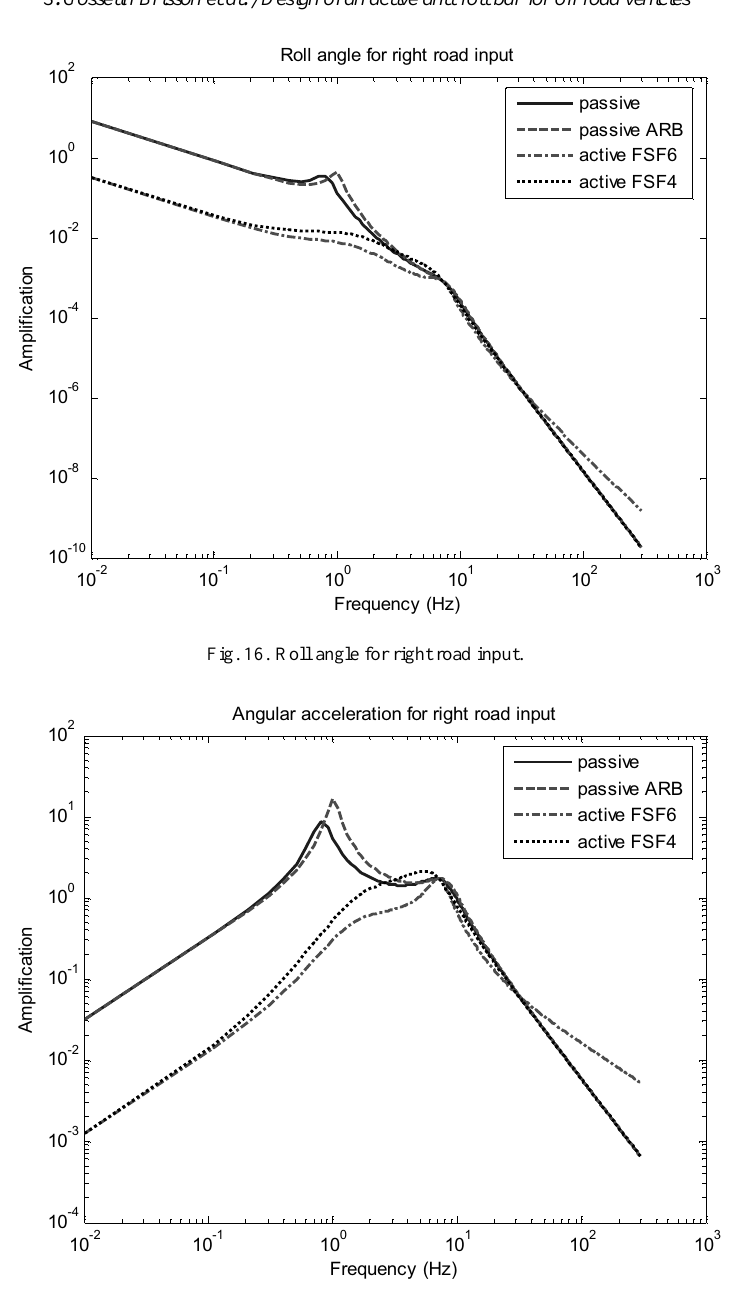
Fig. 17. Angular acceleration for right road